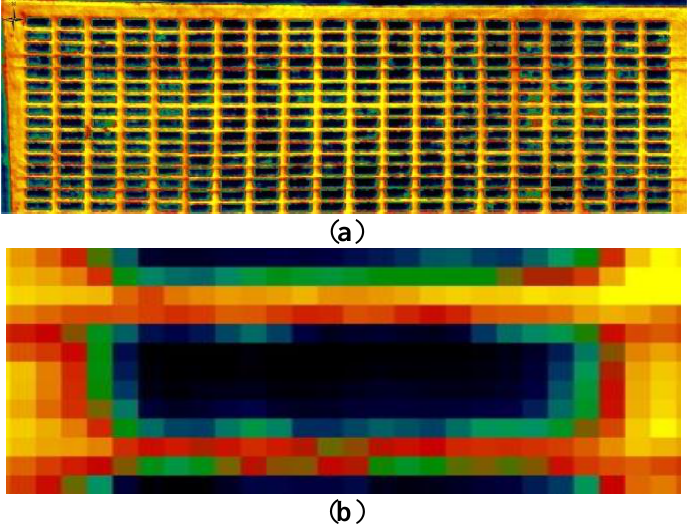
Figure 1. ( a ) Thermal imagery acquired from the study area; ( b ) Detail of a single